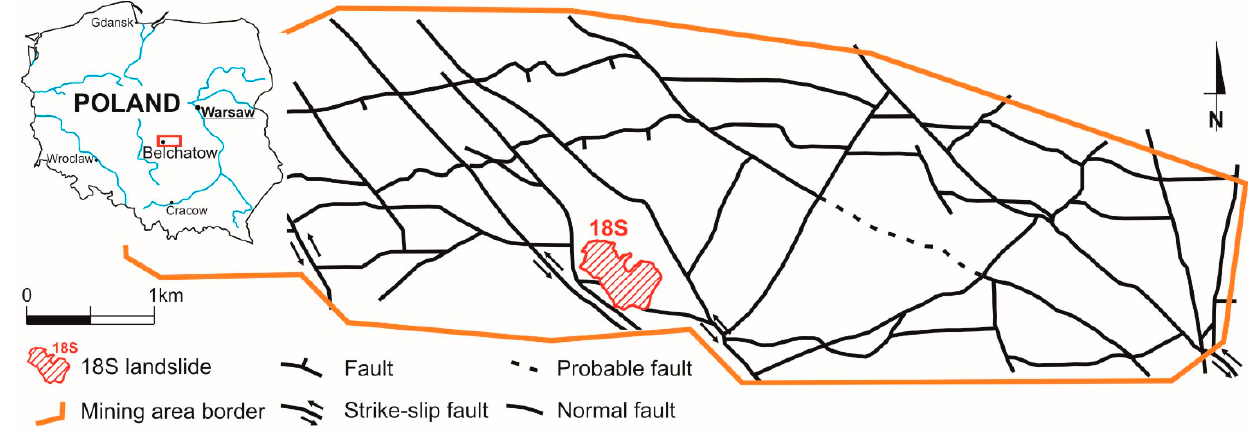
Energies 2021 , 14 , x FOR PEER REVIEW Figure 2. The sketch of the 18S landslide location on the Be ł chatów mining area. Figure 2. The sketch of the 18S landslide location on the Bełchat ó w mining area.